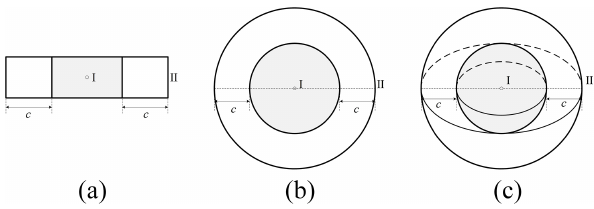
Figure 1. Classification of clearance